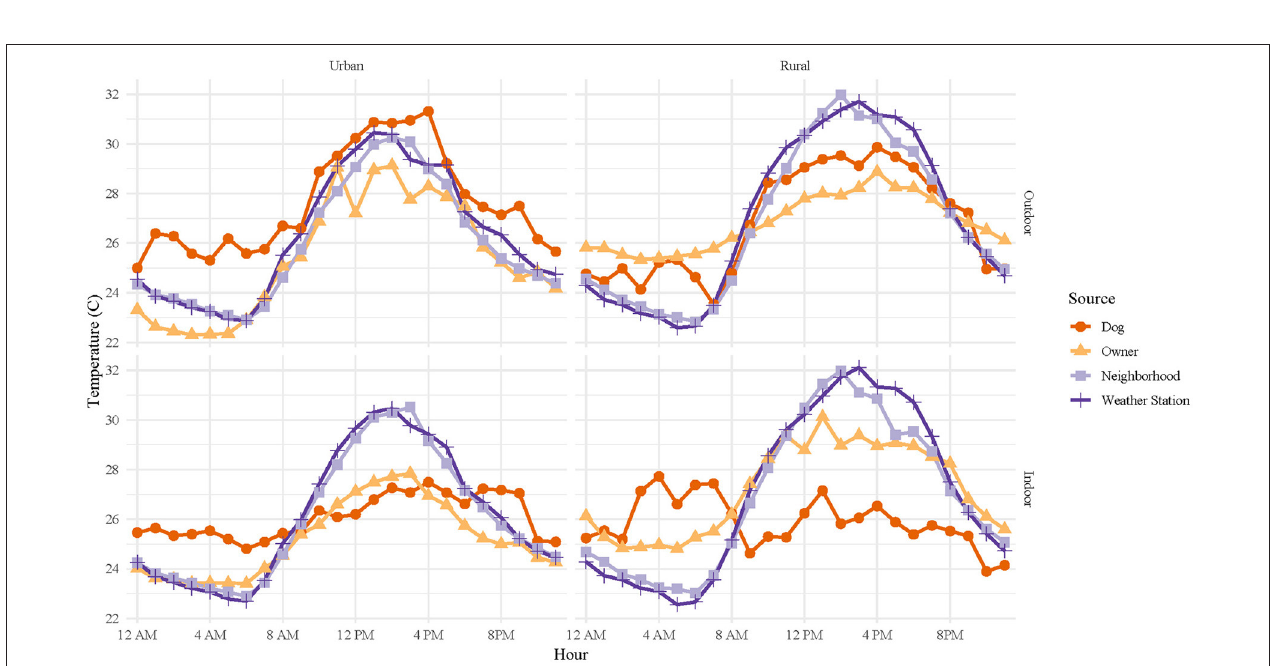
FIGURE 4 | Diurnal variation of mean hourly temperatures for all canine pets’ thermometers, owners’ thermometers, neighborhood thermometers, and nearest weather station, stratified by location (urban or rural) and home environment (outdoor or indoor). Canine pet and owner data were collected over a 6-day period for each dog, with staggered enrollment over a 10-day period in July 2017, using wearable iButton ® thermometers. Neighborhood ambient temperatures were captured using shielded iButton ® thermometers/hygrometers placed in neighborhoods and weather station data was downloaded from the National Weather Service weather station data